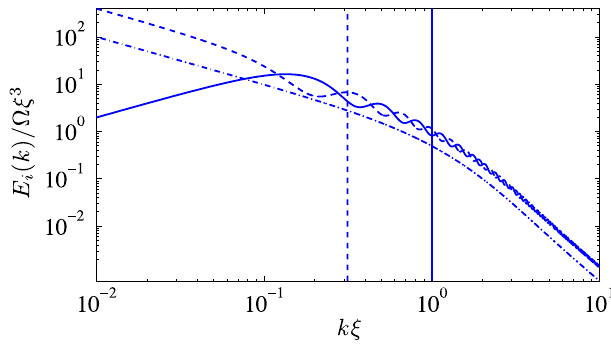
FIG. 3. Incompressible kinetic-energy spectra for a single vor- tex (chain line), a vortex dipole (solid line), and a vortex pair (dashed line). The vortex dipole and pair are both shown for vortex separation d ¼ 20 (cid:1) , and the wave number k shown as a vertical dashed line. The crossover scale k(cid:1) ¼ 1 is given by the solid vertical